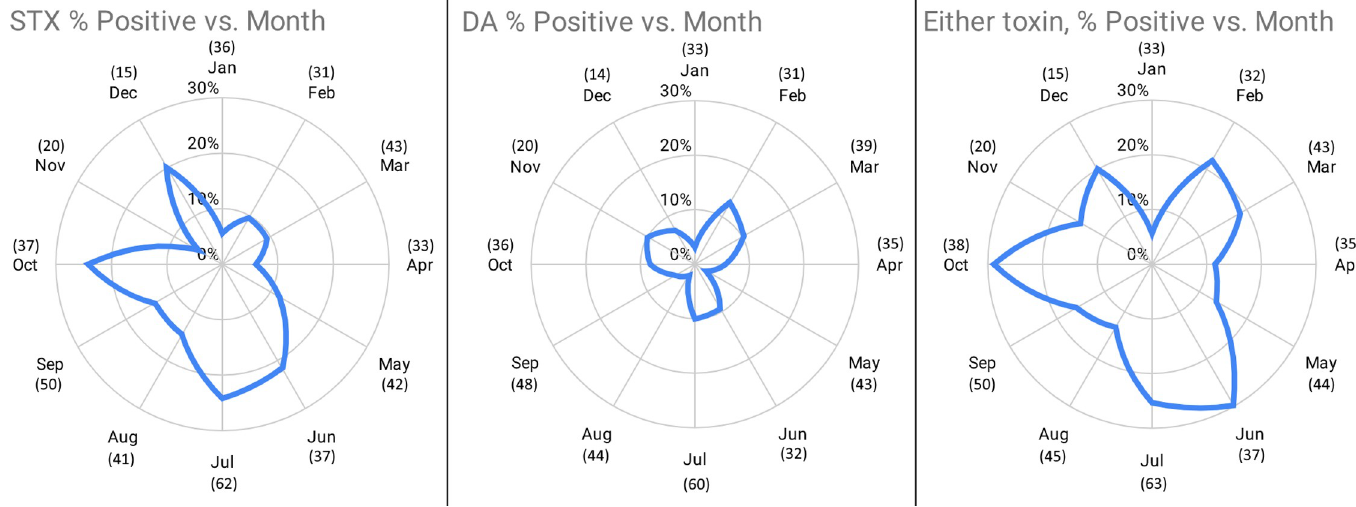
Fig 6. Frequency of animals testing positive for saxitoxin, domoic acid or either toxin, by month.